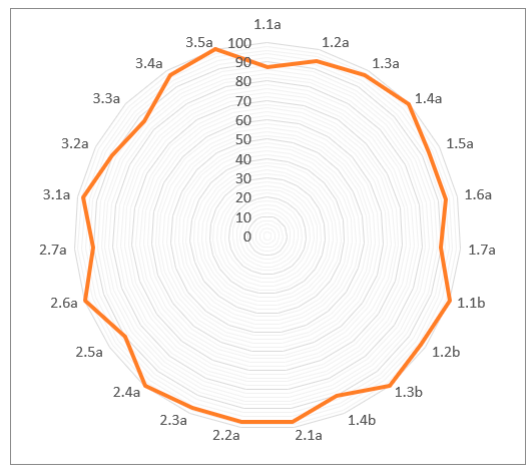
Figure 2. Radar graph showing the percentage agreement for individual test criteria (%).